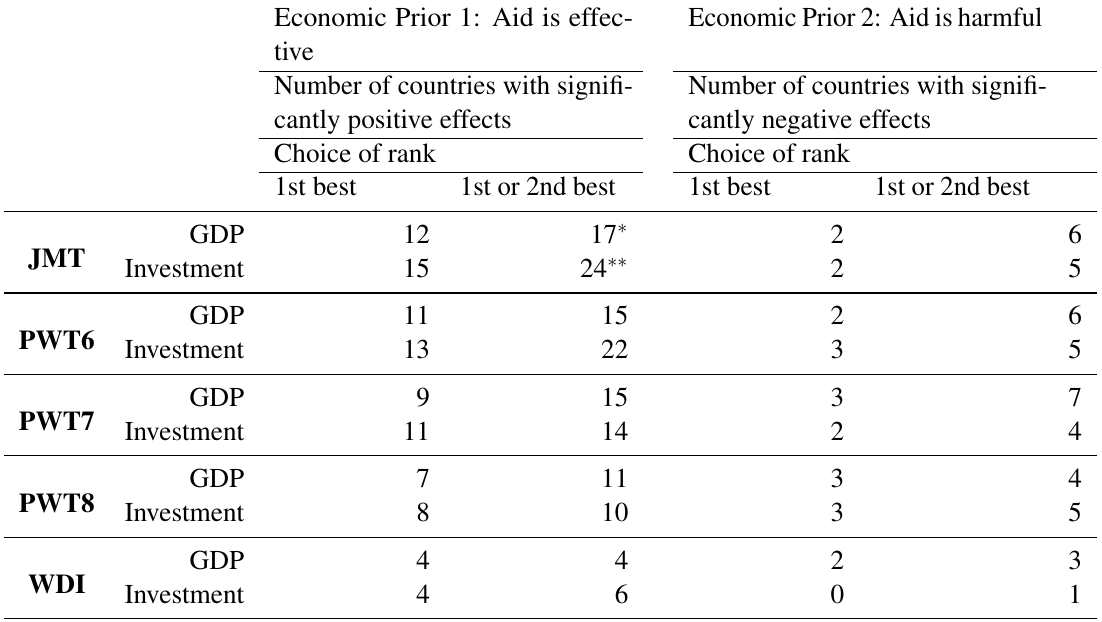
Table 5: Sensitivity analysis of the effect of aid on GDP and investment under two different economic priors Economic Prior 1: Aid is effec- Economic Prior 2: Aid is harmful tive Number of countries with signifi- Number of countries with signifi- cantly positive effects cantly negative effects Choice of rank Choice of rank 1st best 1st or 2nd best 1st best 1st or 2nd best GDP 12 17 ∗ JMT